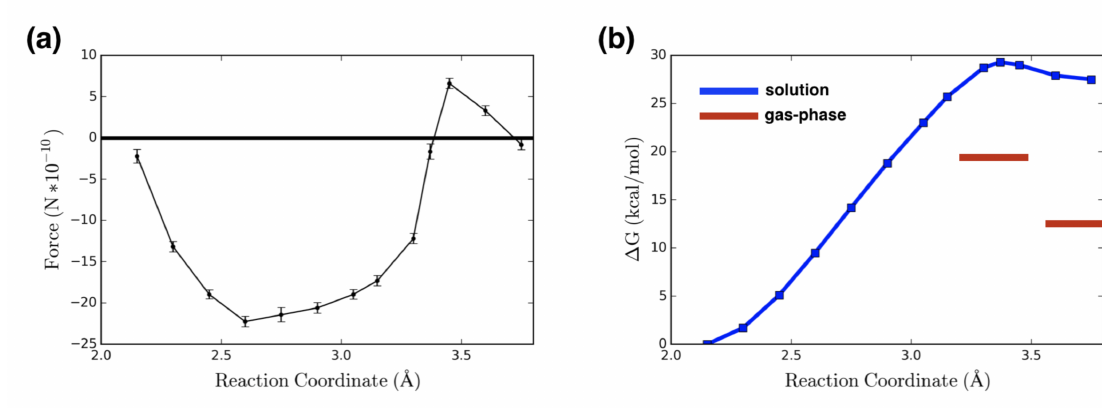
Figure 2. ( a ) Constrained force profile for the catalyst activation pathway for complex A . The statistical errors are calculated with a 95% confidence interval, and ( b ) the corresponding free energy profile in solution along with our estimates obtained from gas-phase